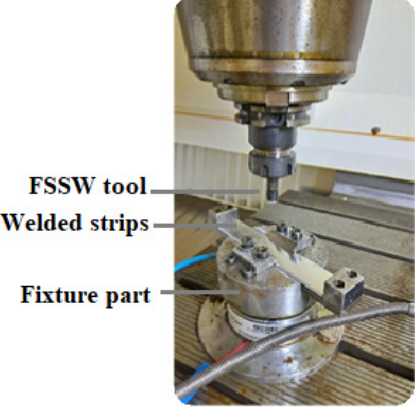
Figure 3. Friction stir spot welding machine setup. Spindle speed (SS), tool feed rate (FR), and plunging depth (PD) were the static friction stir spot welding parameters, while the fixed values of feed rate (FR) and spindle speed (SS) throughout the welding stroke were considered as dynamic parameters, as shown in Figure 4.